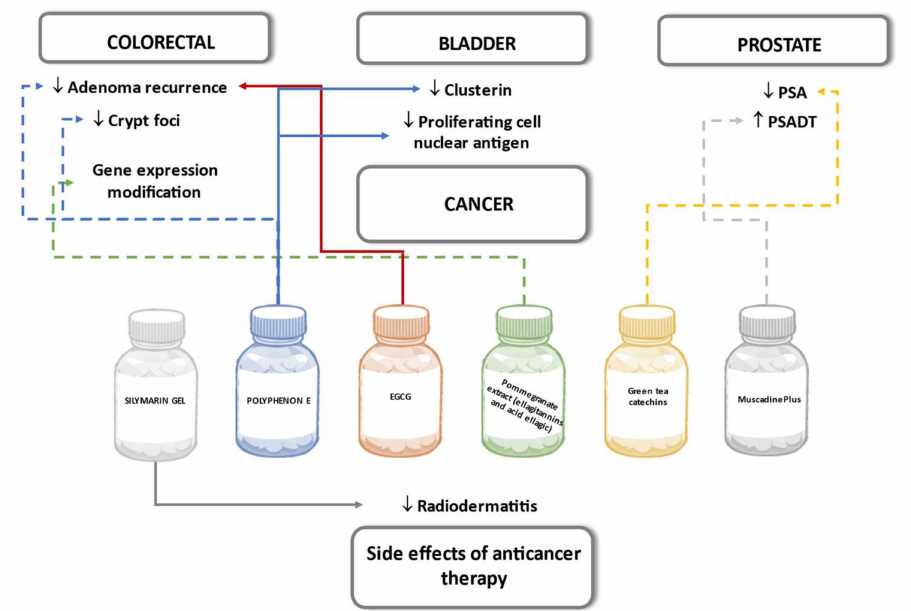
Figure 9. Effects of polyphenols on cancer in human studies. Dashed lines indicate a lack of significant